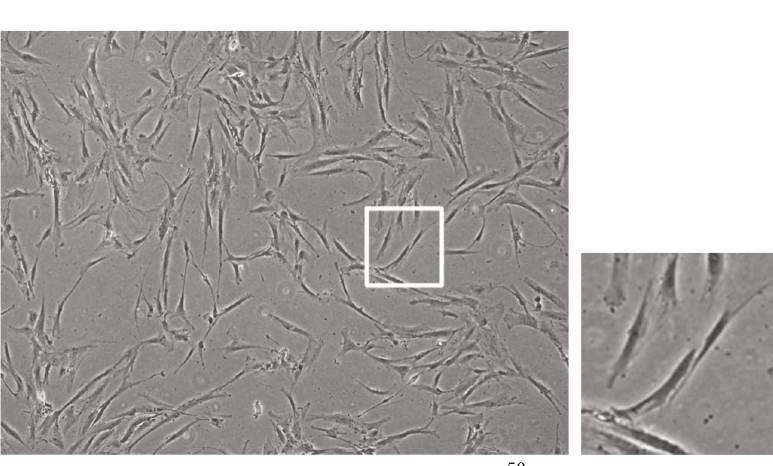
Figure 3: Plastic adherence and morphology of mesenchymal stem cells isolated from the infrapatellar fat pad, representative view using bright fi eld